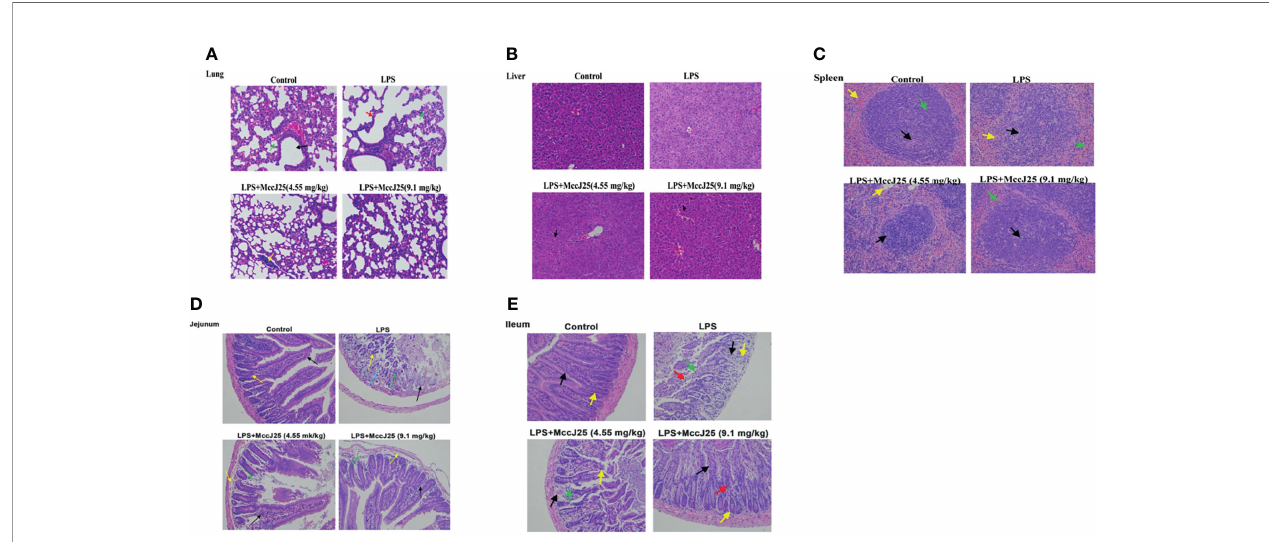
FIGURE 8 | MccJ25 inhibits LPS-induced intestinal and organ injury. (A-E) Representative histopathological images of processed lung (A) , liver (B) , spleen (C) , jejunum (D) , and ileum (E) sections with H&E staining. Images are presented at a magni fi cation of 40 ×. Data are presented as the means ± standard error of mean from 6 biological replicates. Detailed information on different colors of arrows is provided in the Supplementary Files ( Figure 11E ), spleen ( Figure 11F ) had greater positive clinically source MDR E. coli colonization than the uninfected group.